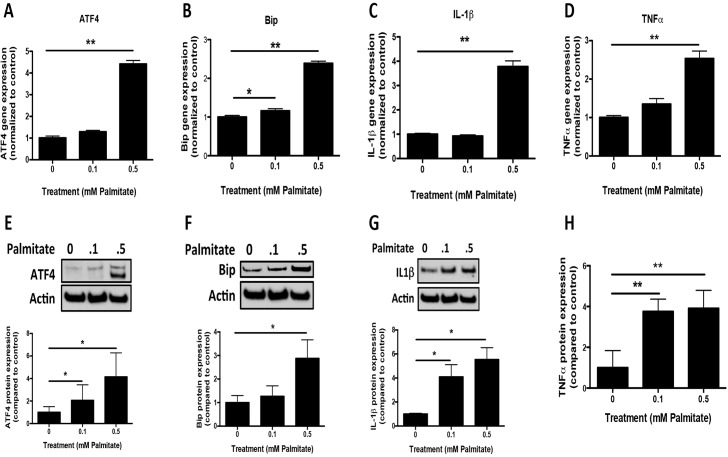
Unfolded protein response and proinflammatory gene expression profiling in primary astroyctes.Primary astrocytes were treated with 0.1 or 0.5 mM Palmitate (Pal) for 48 hours. mRNA and protein were isolated for RT-PCR, western blotting and ELISA analysis. UPR (ATF4 (A) and Bip (B)) and proinflammatory (IL1beta (C) and TNFα(D)) gene expression were measured by qRT-PCR in primary astrocytes. The protein level of ATF4 (E), Bip (F) and IL1beta (G) were determined by western blotting analysis. Quantification of western blot signals was normalized by actin expression and compared to control. H. ELISA analysis of TNFα secretion in the media of astrocyte culture with palmitate treatment. The quantification was compared to control (n = 4). Results were compared to control and presented as mean±SEM, *p<0.05, **<0.01, ANOVA with Student-Newman-Keuls post hoc analysis.